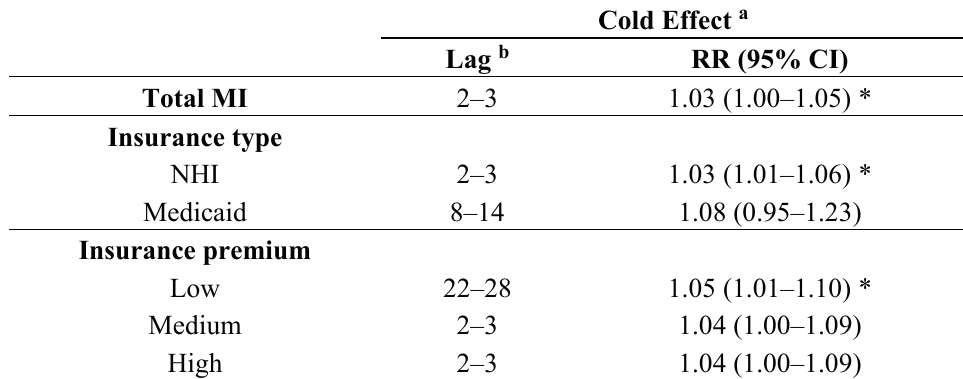
Table S2. The relative risk (RR) of cold effects on AMI hospital admissions in cold weather period by gender, age, and